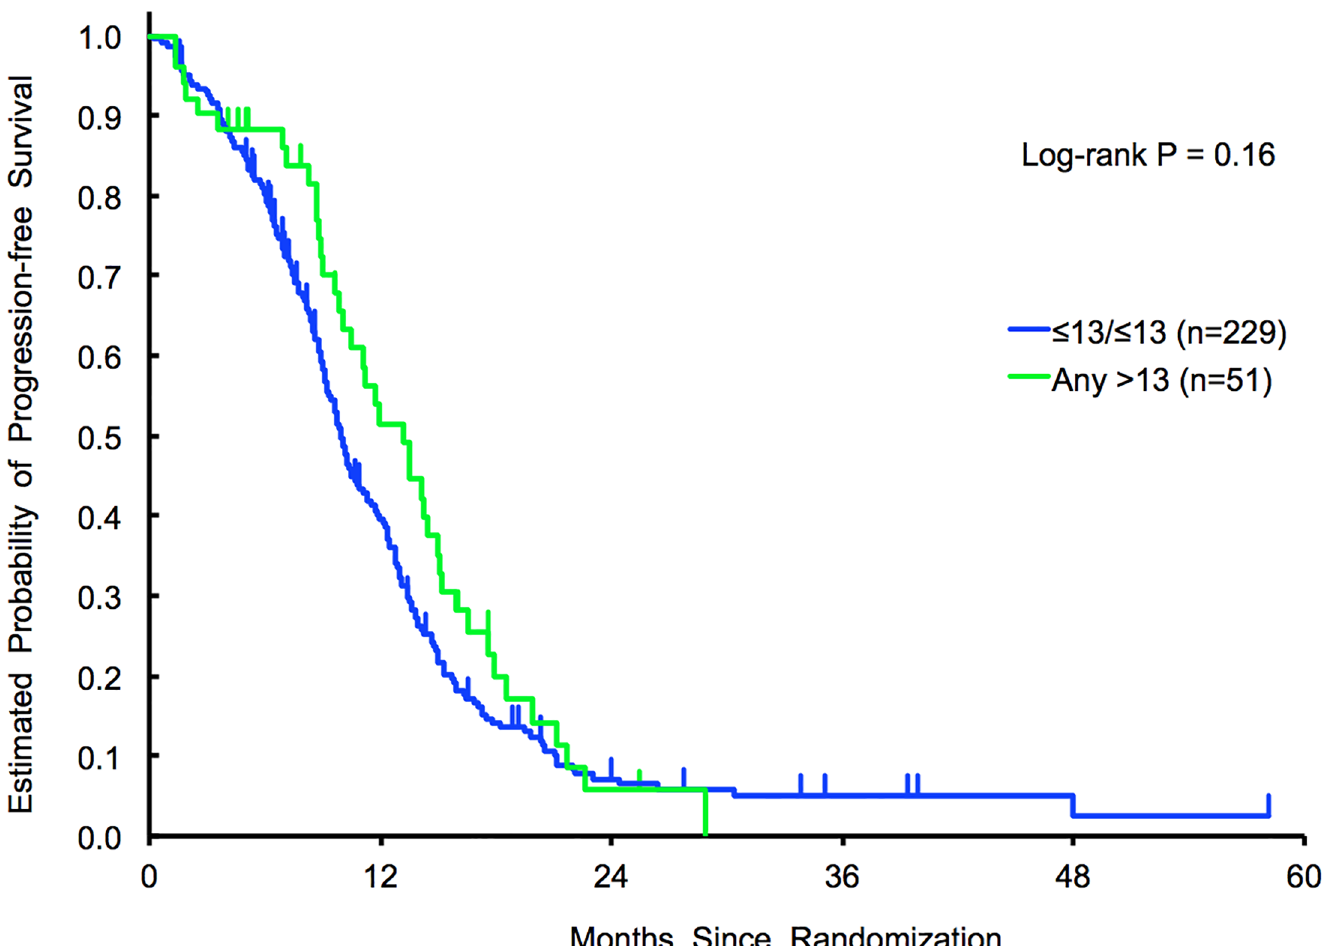
Fig 3. Validation cohort 1 (FIRE-3). PFS results in any > 13 repeats vs (cid:20) 13/ (cid:20) 13repeats .